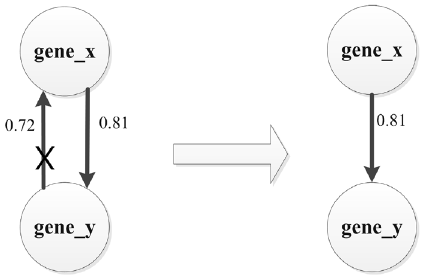
Figure 12. Screening for one-way gene regulatory relationships.